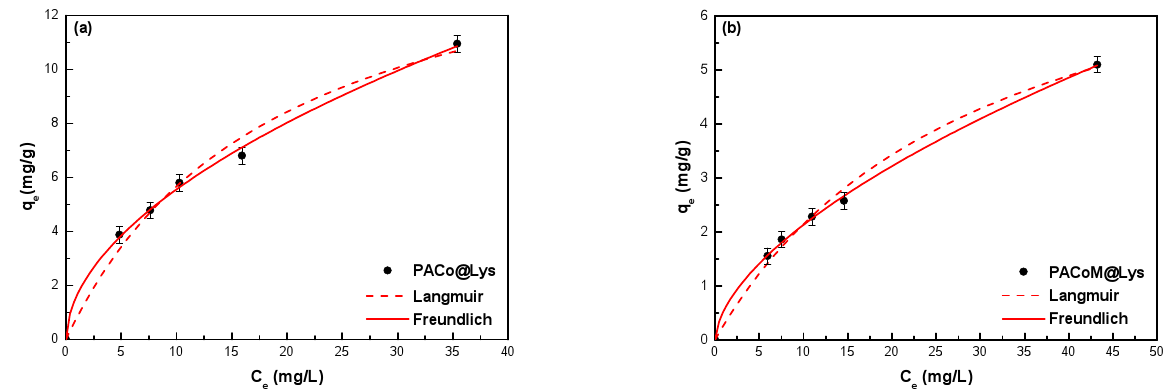
Figure 10. Equilibrium adsorption data fitted using the Langmuir and Freundlich isotherms for ( a ) the PACo–Lys samples and ( b ) the PACoM–Lys samples. Table 4. Parameters of the Langmuir and Freundlich models for ASA adsorption.